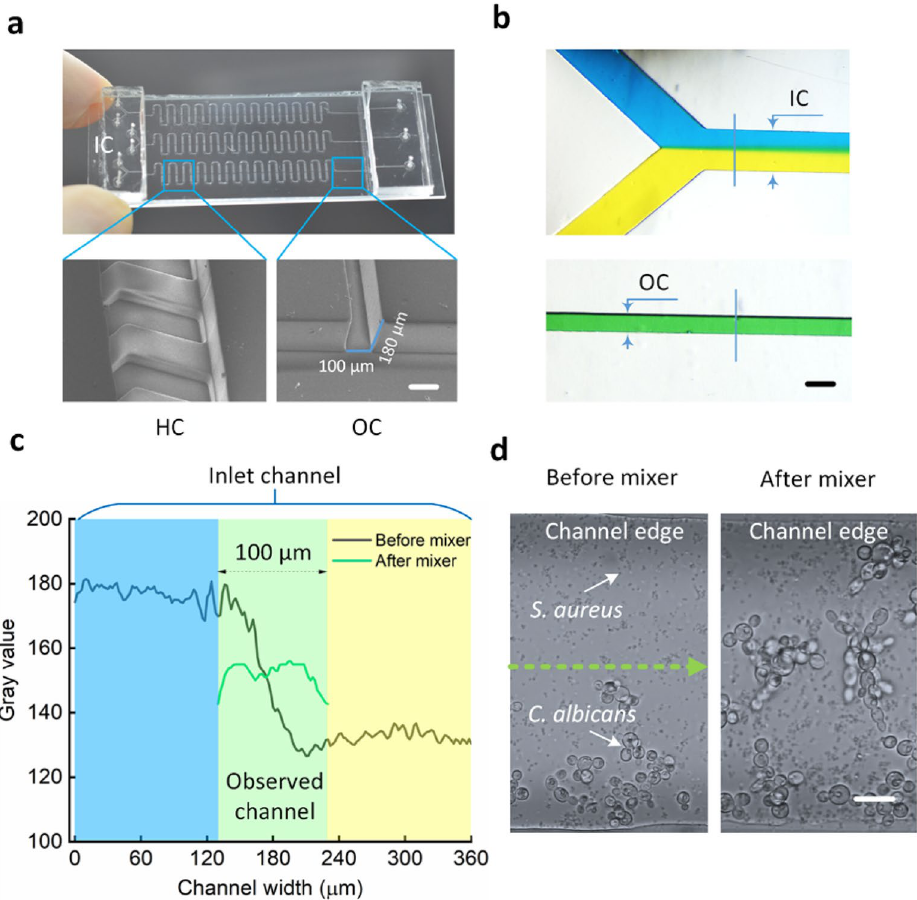
Figure 1. Microfluidic channel visualization and mixing capability: ( a ) overview of the proposed microfluidic chip (top) and scanning electron microscopy (SEM) images of herringbone (bottom-left) and observed (bottom- right) channels ( IC inlet channel, HC herringbone channel, OC observed channel; scale bar in ( a ) = 100 µm), ( b ) colour mixing effect before (top) and after (bottom) the herringbone mixer (scale bar in ( b ) = 100 µm), ( c ) grey value measured from blue lines on colour mixing images ( b ) before and after the herringbone mixer, and ( d ) bacterial and fungal mixtures before and after the herringbone mixer at the injection phase (scale bar in ( d ) = 10 µm). The top line represents inlet channels with two apparent colour areas (blue and yellow), which were then mixed thoroughly into a green colour area on the observed